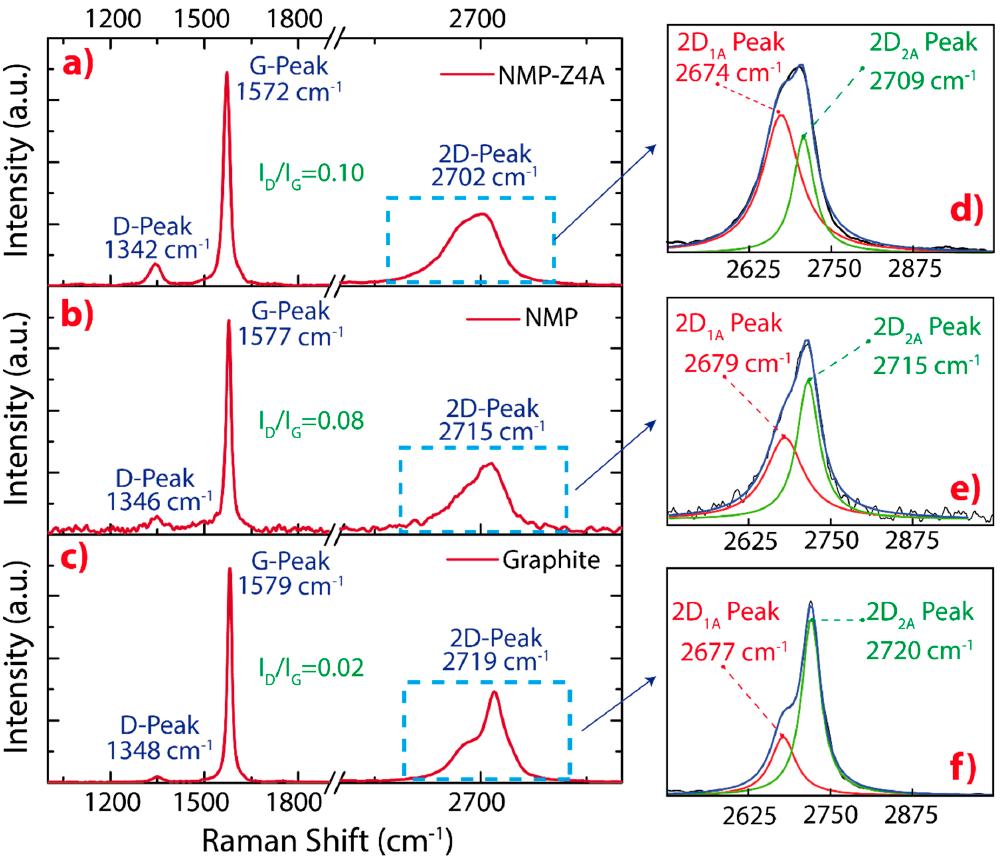
Figure 2. Raman spectrum of ( a ) graphene dispersed in NMP+Z4A, ( b ) graphene dispersed in NMP, and ( c ) pristine graphite. ( d–f ) Fitting of the 2D peaks with two Lorentzian functions. The intensity normalized by the G peak.